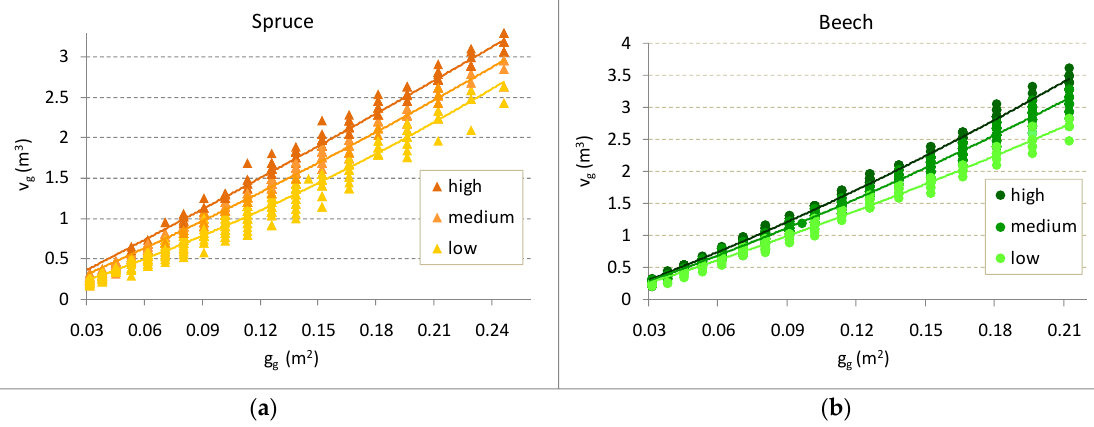
Figure 6. Relationship between mean tree volume ( v g ) and basal area ( g g ) in spruce ( a ) and beech ( b